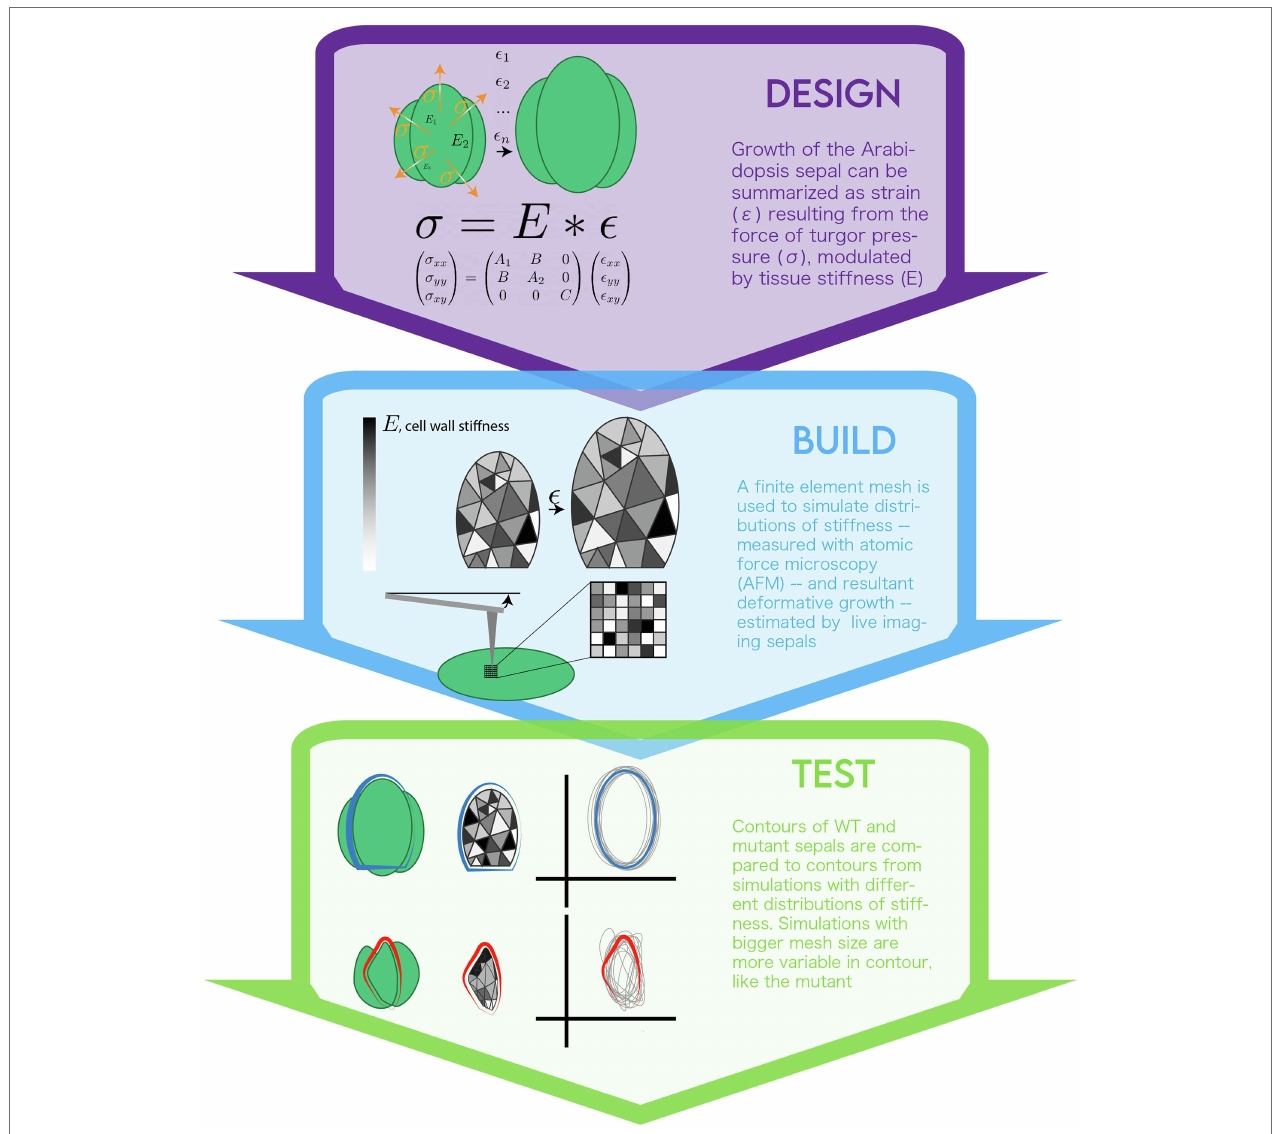
FIGURE 2 | The modeling life cycle used to implement a biomechanical model of sepal